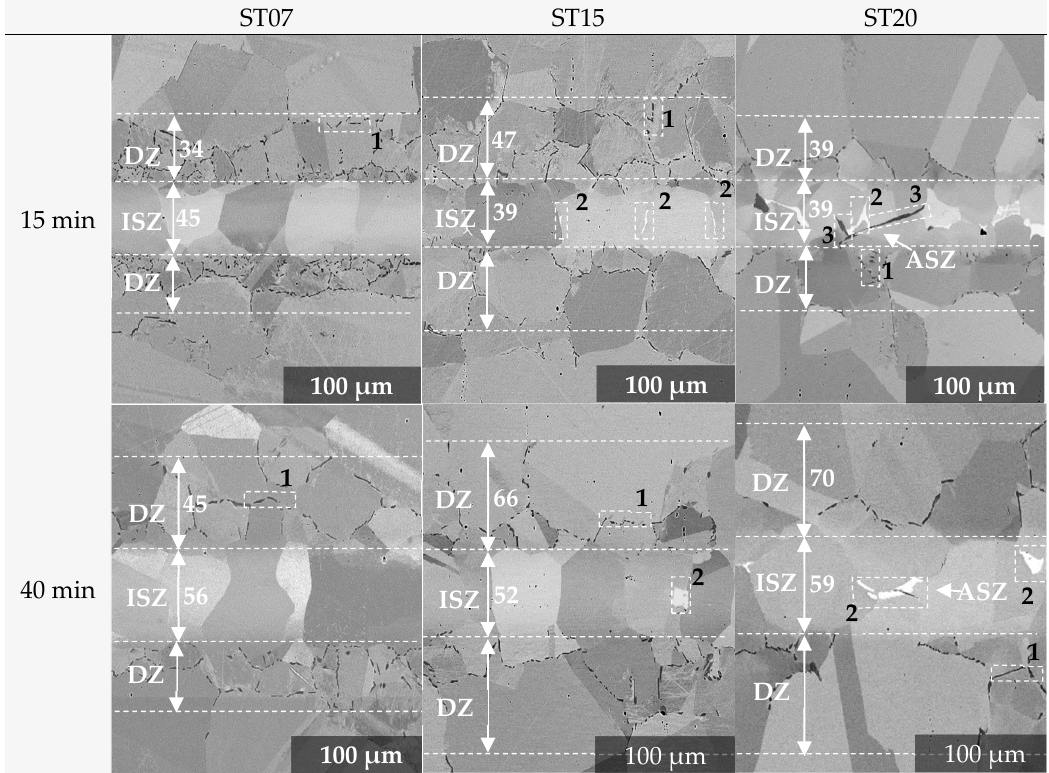
Figure 9. Cross ‐ sections of the brazing seam with scanning electron microscopy (SEM) with Figure 9. Cross-sections of the brazing seam with scanning electron microscopy (SEM) with backscattered electron (BSE) backscattered electron (BSE) detector (all dimensions of white numbers in μ m). detector (all dimensions of white numbers in µ